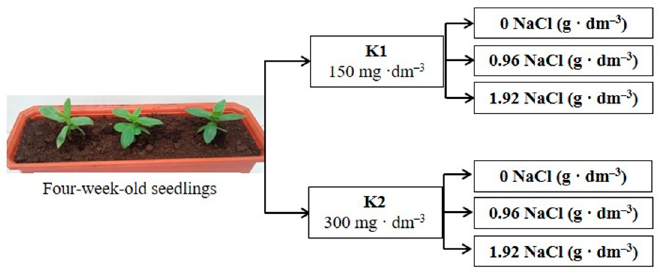
Figure 9. The schematic diagram of experiments; K1 and K2—potassium levels.